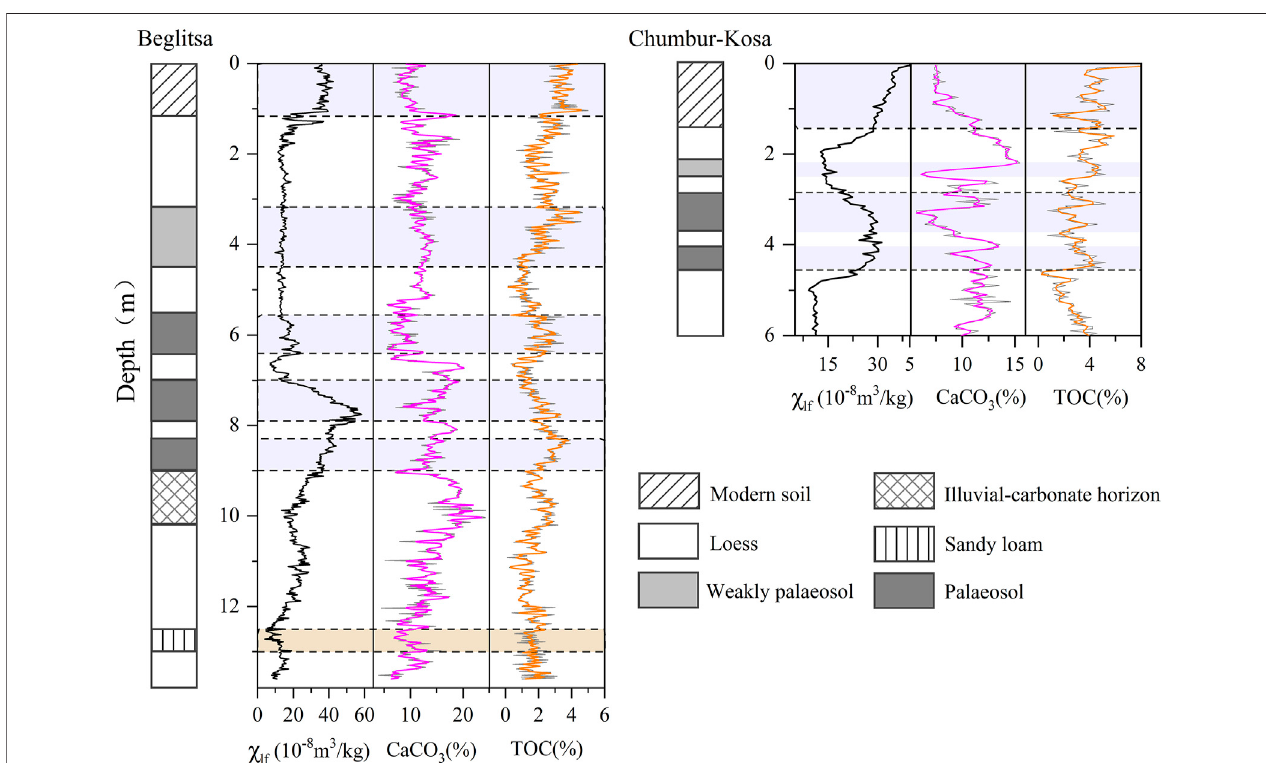
FIGURE5| CaCO 3 %andtotalorganiccarboncontent(TOC)proxiesagainst χ lf variationsintheBeglitsaandChumbur-Kosasections(theCaCO 3 %andTOCdata have been smoothed by fi ve points using adjacent-averaging method).